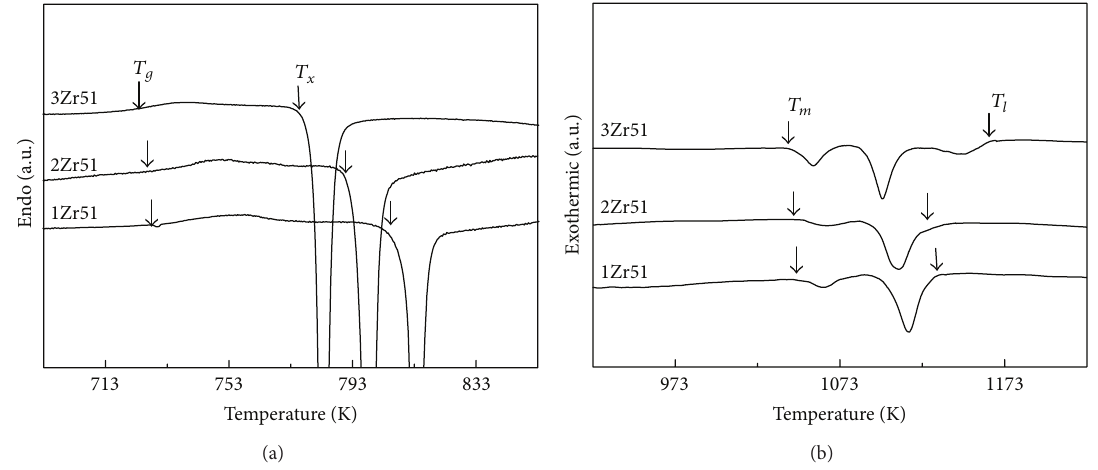
Figure 5: The DSC (a) and DTA (b) curves for as-cast 1Zr51, 2Zr51, and 3Zr51 BMG